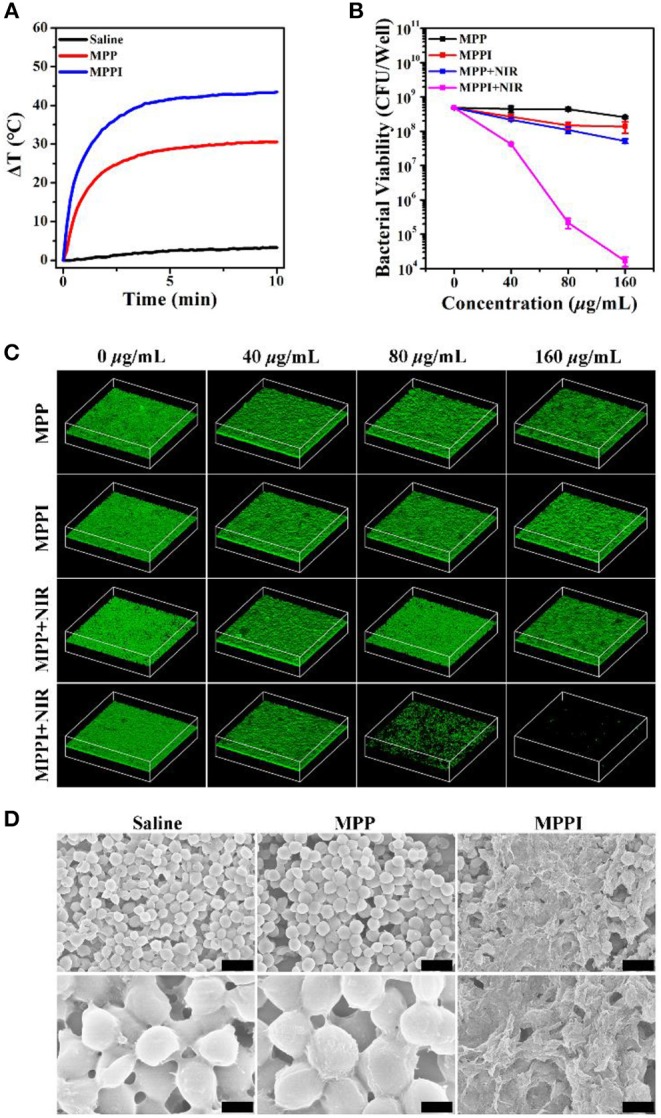
In vitro targeted PTT of S. aureus biofilms. (A) Temperature changing curves of S. aureus biofilms under 785 nm laser irradiation (0.58 W/cm2, 10 min) after 6 h incubation with saline, MPP NSs, and MPPI NSs (MoS2: 160 μg/mL), respectively. (B) Bacterial viability and (C) Three dimensional (3D) confocal laser scanning microscopy (CLSM) images (630 × 630 μm) of S. aureus biofilms with or without NIR laser irradiation after incubation with different concentrations of MPP NSs or MPPI NSs. (D) Representative SEM images of S. aureus biofilms after PTT of MPP NSs or MPPI NSs (MoS2: 160 μg/mL). The scale bars in upper row and lower row represent 2 μm and 500 nm, respectively.